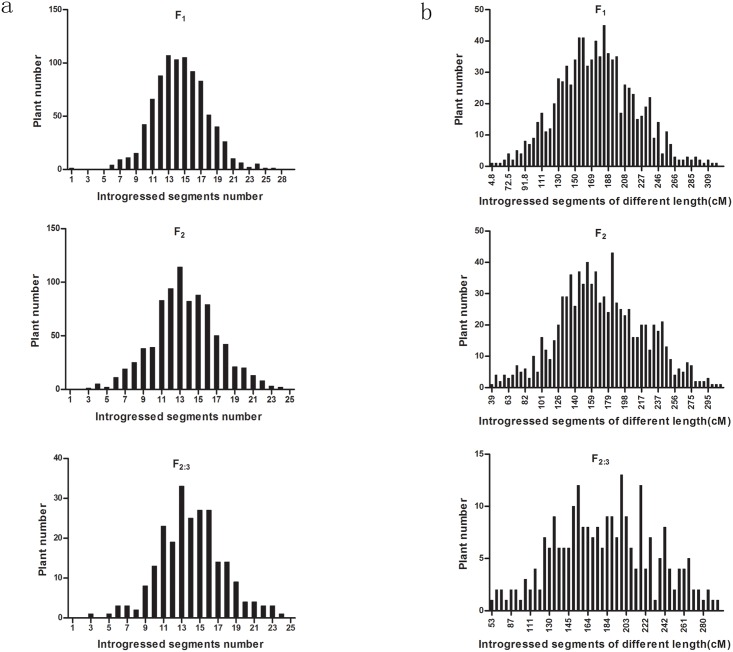
Numbers and total length of the introgressed Hai1 segments in the three generations.a: Number of the introgressed Hai1 segments; b: Total length of the introgressed Hai1 segments.